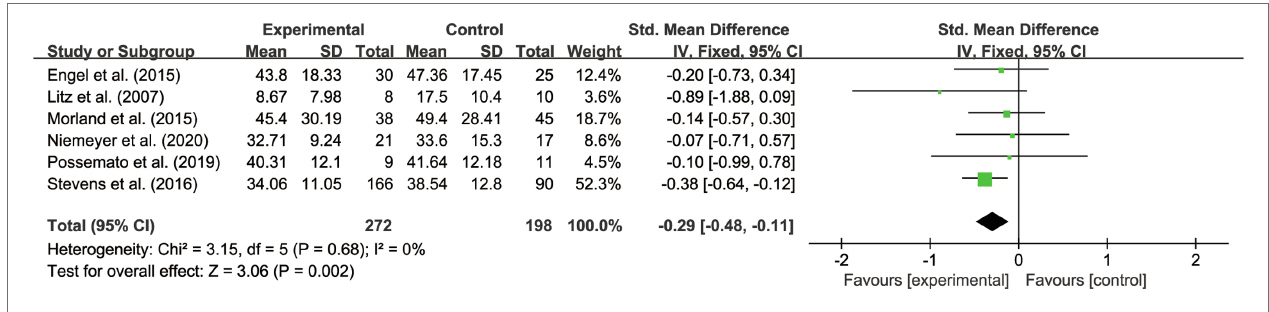
FIGURE 3 | Forest plot of overall effectiveness of IBI on veterans with